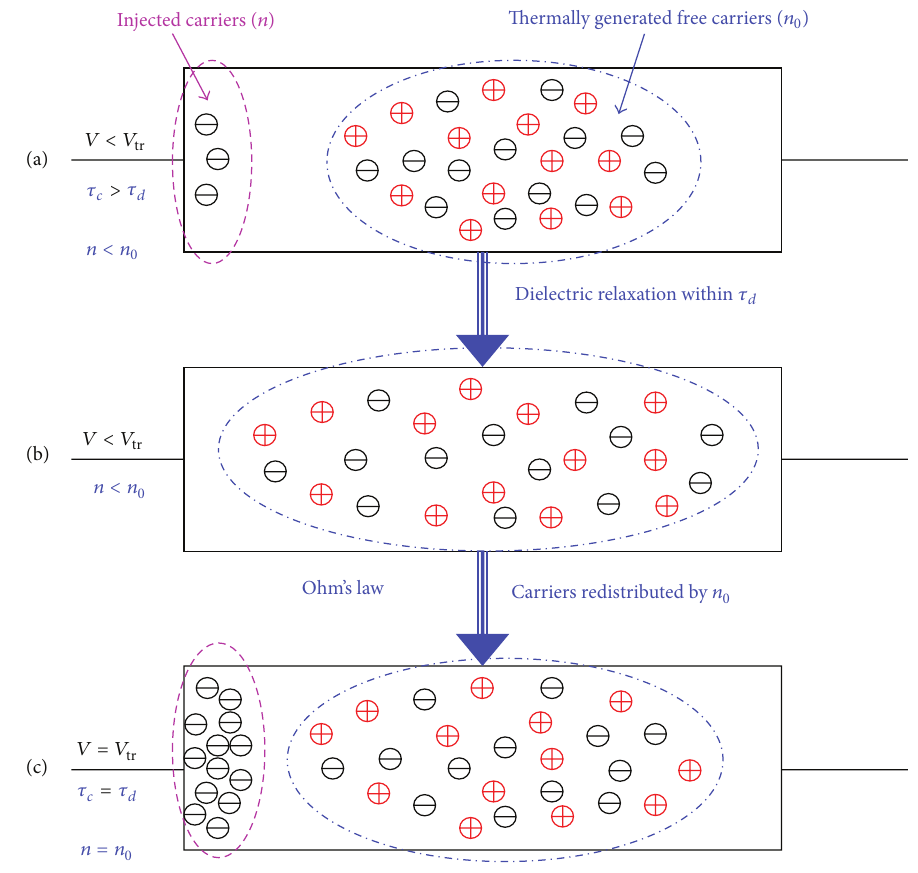
Figure 25: Carriers distribution in dielectric film under carrier weak injection ( 𝑉 ≤ 𝑉 tr ) in space-charge-limited conduction. (a) Very weak injection ( 𝑉 < 𝑉 tr , 𝑛 < 𝑛 0 , 𝜏 𝑐 > 𝜏 𝑑 ), (b) dielectric relaxation and carriers redistribution, and (c) weak injection at 𝑉 tr ( 𝑉 = 𝑉 tr , 𝑛 = 𝑛 0 , 𝜏 𝑐 = 𝜏 𝑑 ). 𝑛 is the concentration of injected carriers; 𝑛 𝑉 tr is the transition voltage at the onset of departure from ohm’s law; 0 is the concentration of thermally generated free carriers in dielectric film; 𝜏 𝑐 is the carrier transit time; 𝜏 𝑑 is the dielectric relaxation